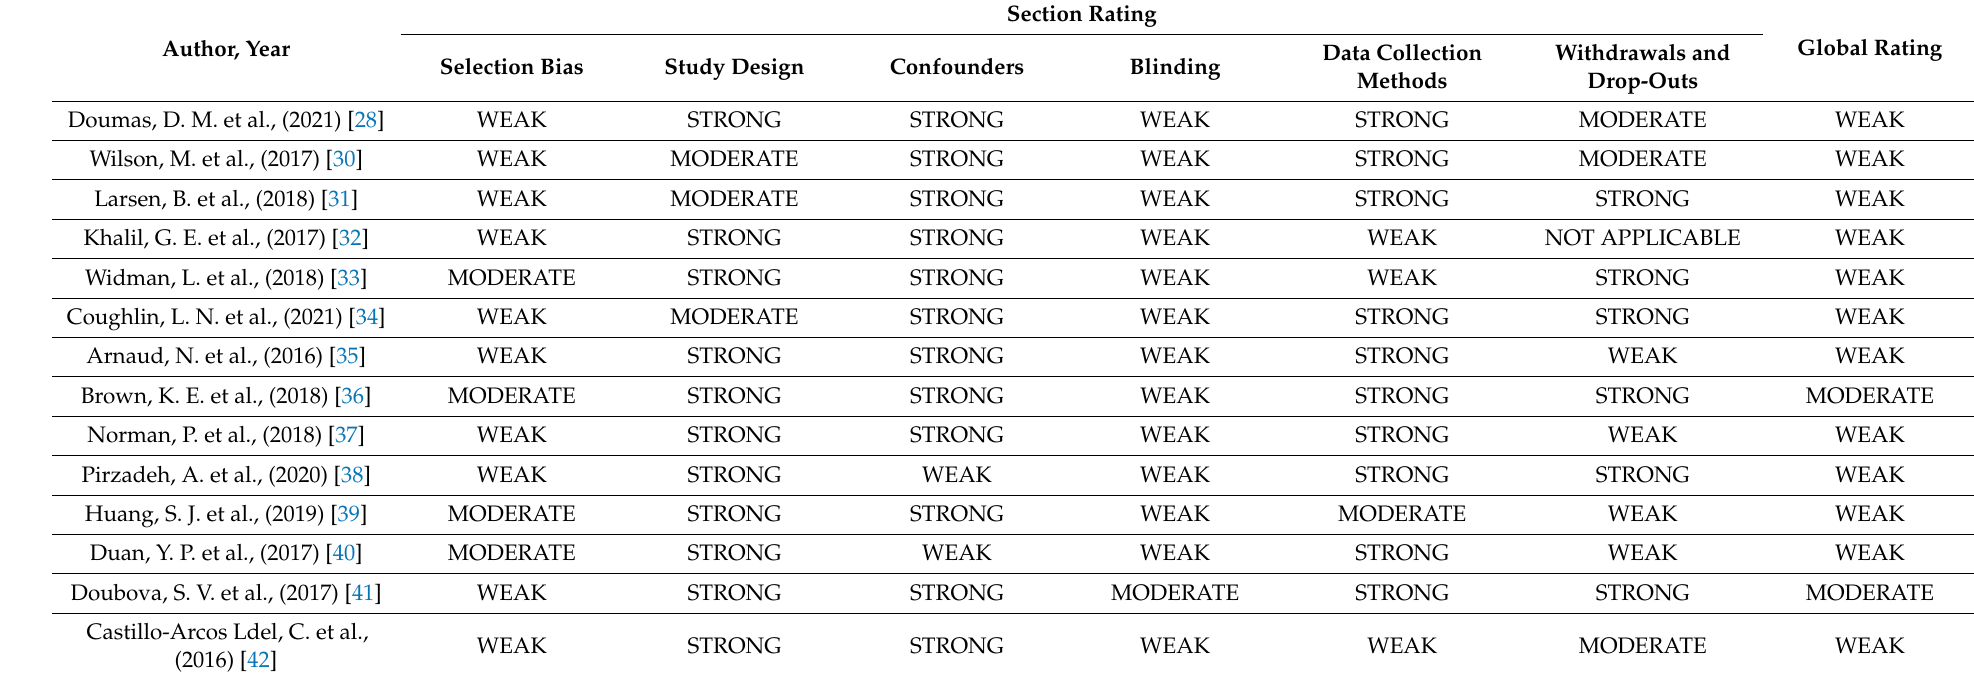
Table 3. Risk of Bias Assessment—EPHPP Assessment Tool for Quantitative